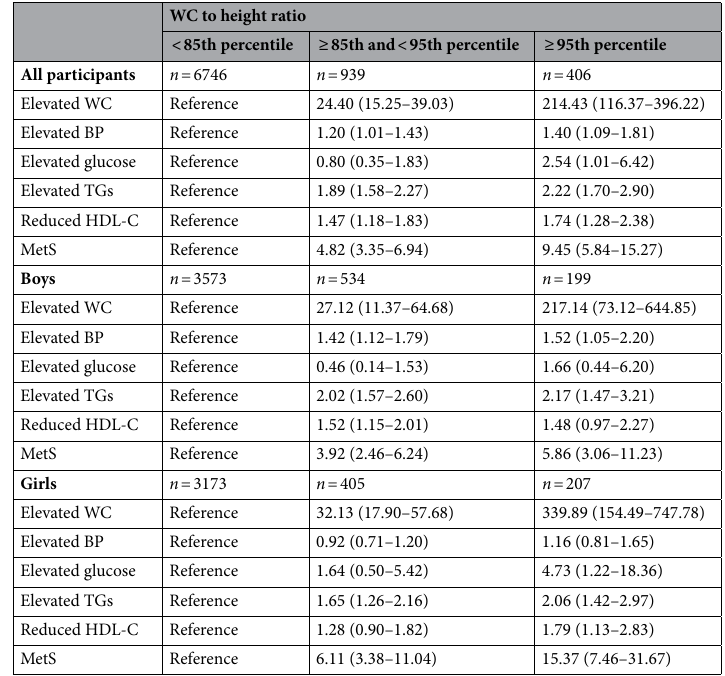
Table 4. The adjusted odds ratio of metabolic syndrome (MetS) and its components according to waist circumference-to-height ratio (WHtR) in Korean children and adolescents ( n = 8091). The adjusted odds ratio and 95% confidence interval were estimated using multiple logistic regression analysis after adjustment for age, sex, body mass index (BMI) standard deviation score (SDS), alcohol consumption, smoking, physical activity, residence, household income, and diagnosis of hypertension, diabetes mellitus and dyslipidemia. WC waist circumference, BP blood pressure, TGs triglycerides, HDL-C high-density lipoprotein cholesterol, MetS metabolic